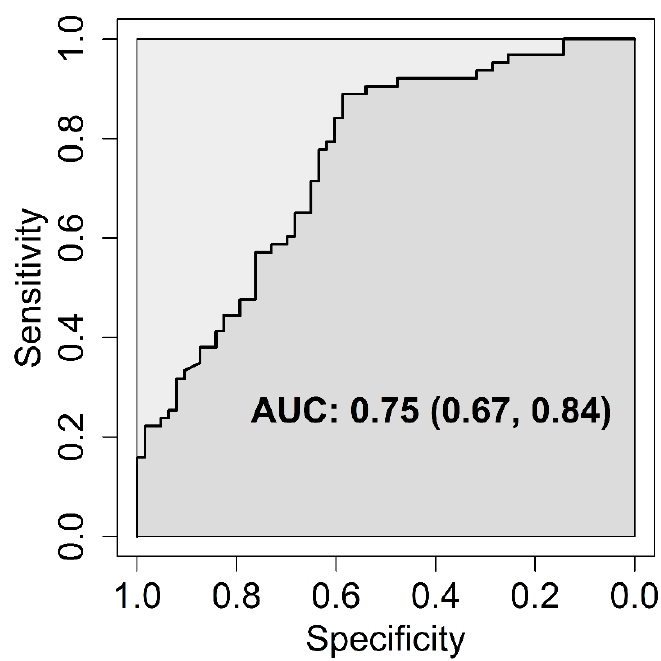
Figure 4. Receiver operating characteristic (ROC) curve. Outcome: bronchiolitis hospitalization; predictor: fitted probability from the logistic regression model.